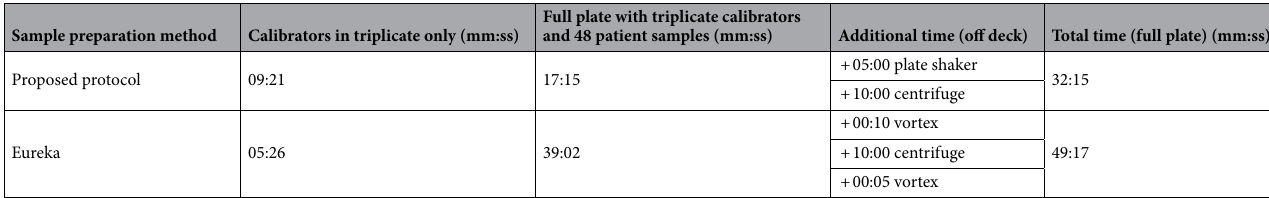
Table 6. Time comparison for the proposed study against a commercial